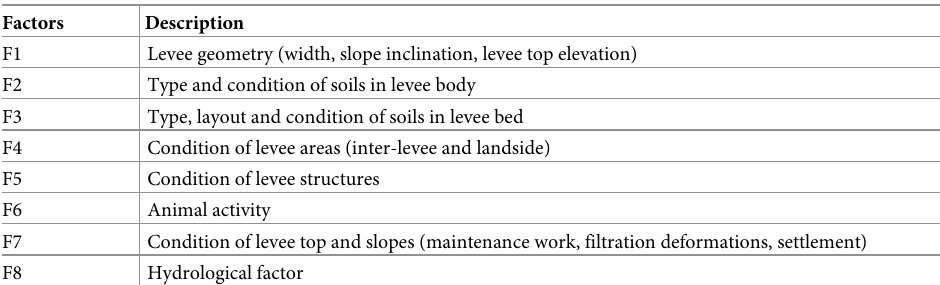
Table 1. Analysed